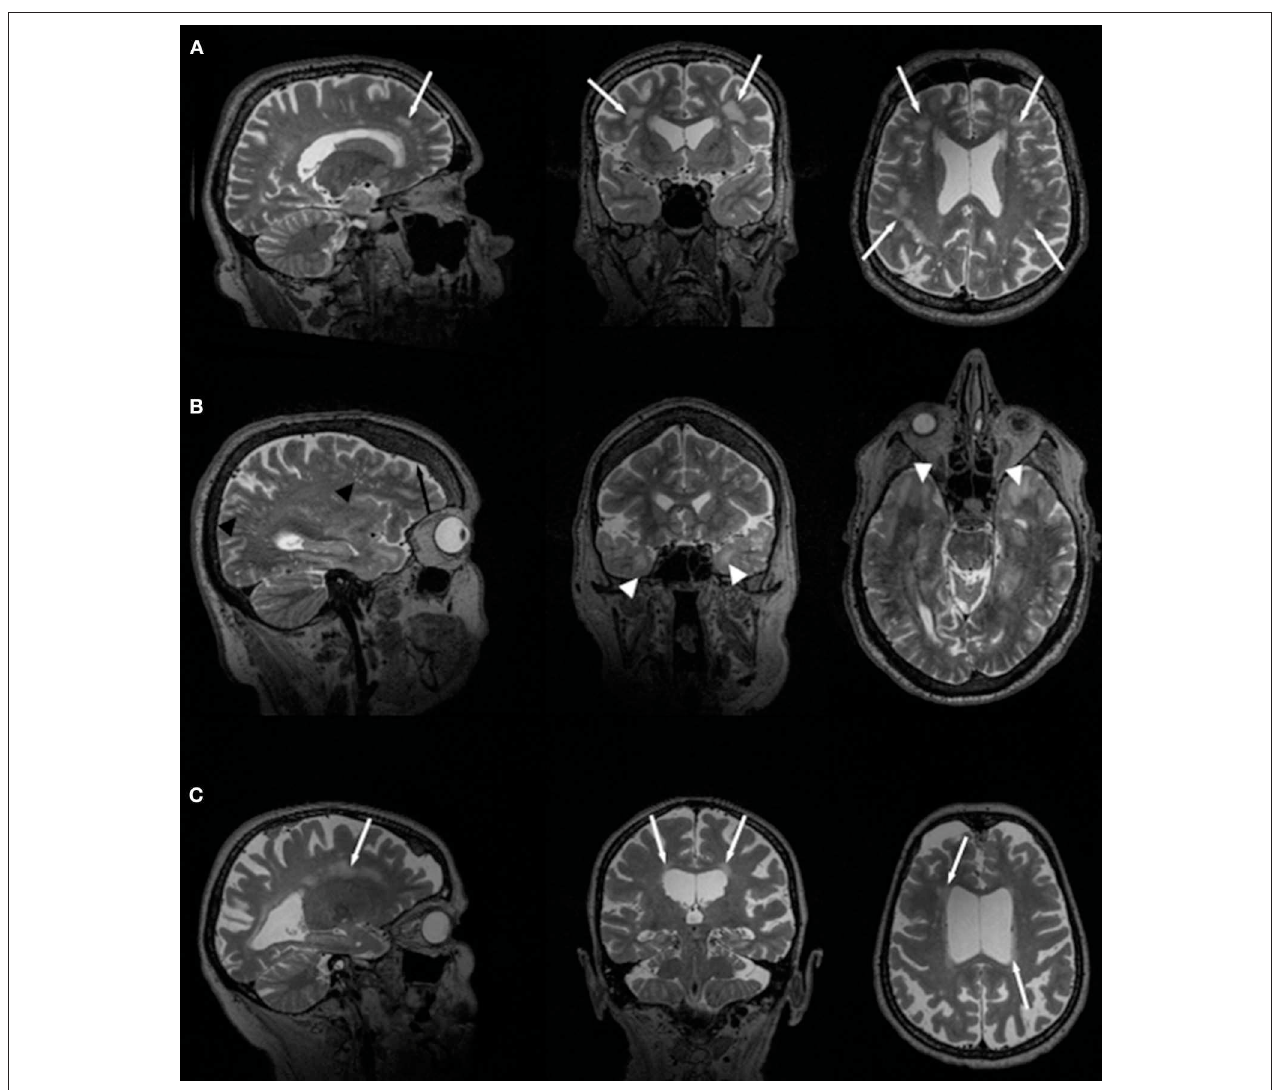
FIGURE 1 | Slices of T2-weighted MR images in two different DM1 (A, B) and one DM2 (C) patients. Global atrophy with ventricle enlargement is seen in all cases. White arrows indicate WMHL, white arrow heads point toward ATWML. Black arrow indicates frontal hyperostosis in DM1 patients, black arrow heads point toward dilated Virchow-Robin